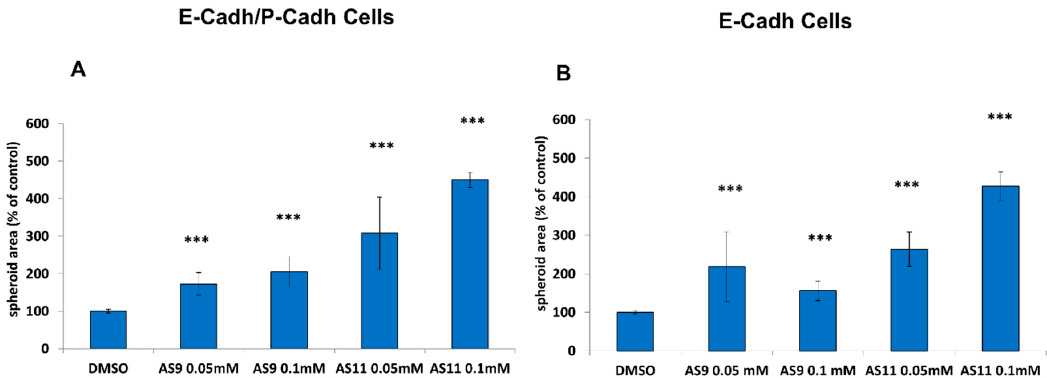
Figure 5. AS11 is more potent than AS9 to impair cell–cell interaction. BxPC-3 E-cadh/P-cadh cells (no cadherin depletion) ( A ) and BxPC-3 E-cadh cells (P-cadherin depletion) ( B ) were incubated in the presence of AS9 or AS11 at various concentrations and allowed to form spheroids in suspension for 24 h. The spheroid area was measured by phase-contrast microscopy and analyzed by ImageJ. A p < 0.05 was considered statistically significant and is indicated by ‘***’ when p < 0.001. See the Materials and Methods section for details on the statistical